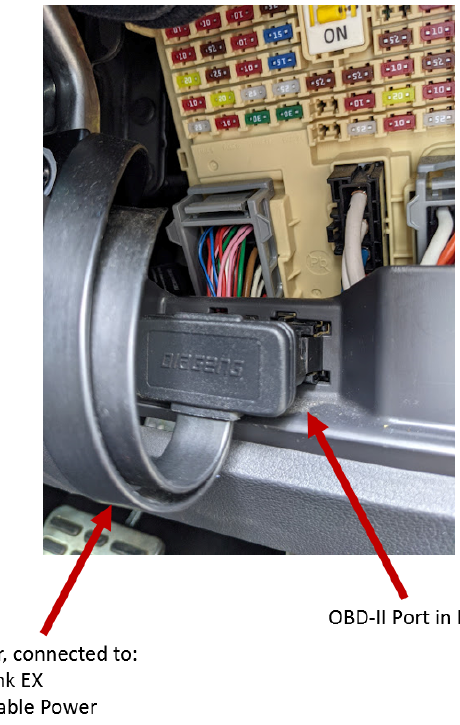
Figure 6. Splitter connected to the OBD-II port under the driver’s side dashboard in the Hyundai Ioniq Battery Electric car to extract OBD-II data as well as provide 5V power to the Raspberry Pi Zero W.